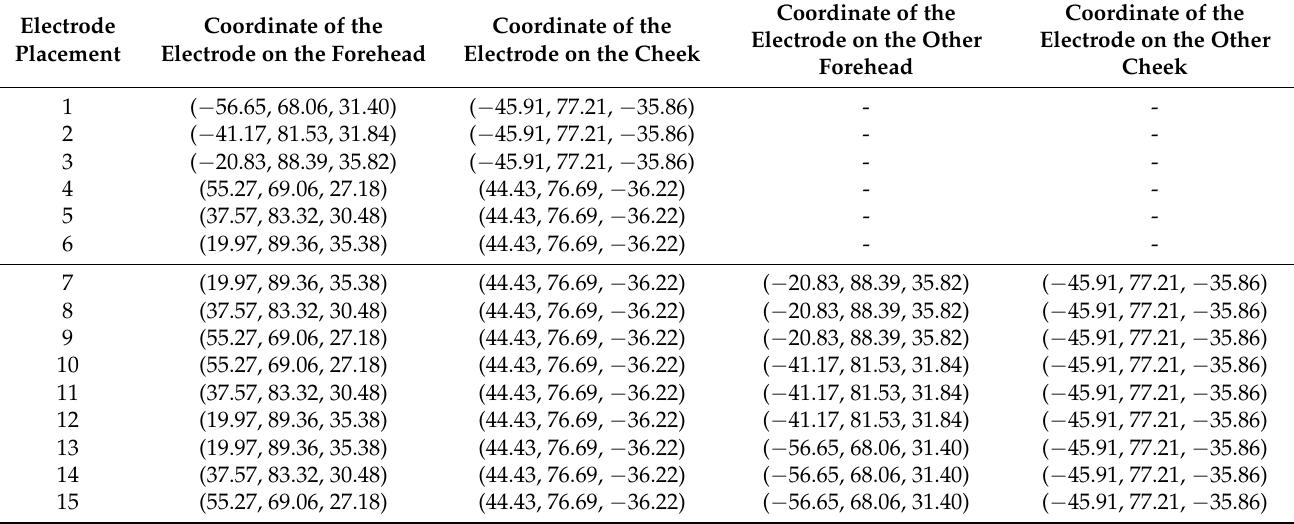
Table 3. The coordinates of each electrode placement used in the first simulation.